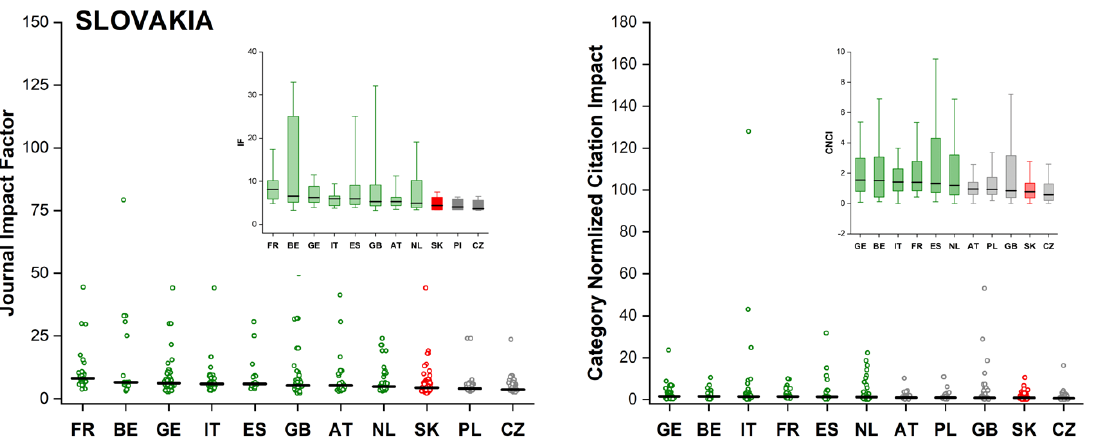
Figure 6. Scientific impact (JIF and CNCI) as a function of the country of affiliation of corresponding authors in Poland. Red open circles: Poland; green open circle: countries with an observed significant difference; open grey circles: no significant difference between the V4 and compared country. Abbreviations: BE = Belgium, CA = Canada, CH = Switzerland, ES = Spain, GB = England, FR = France, GE = Germany, IT = Italy, NL = the Netherlands, PL = Poland, USA = United States.